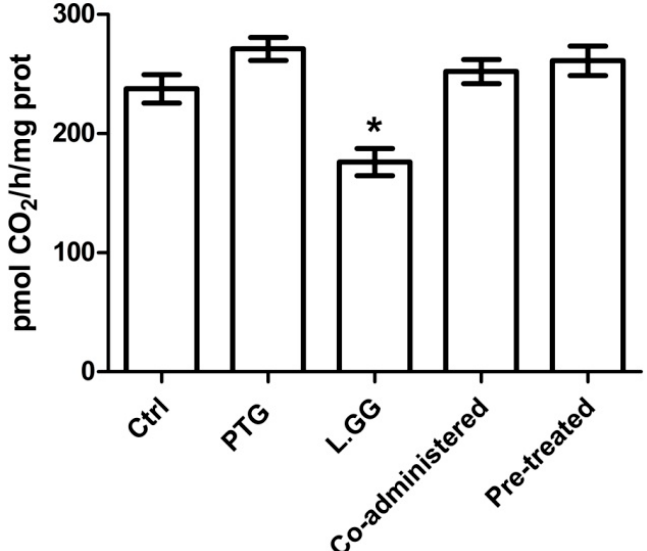
Figure 2. Ornithine Decarboxylase (ODC) activity in jejunal tissue samples from control and treated rats. Ctrl (without treatment); PTG (sensitized with 1000 U IFN- γ and treated with PTG 50 µ